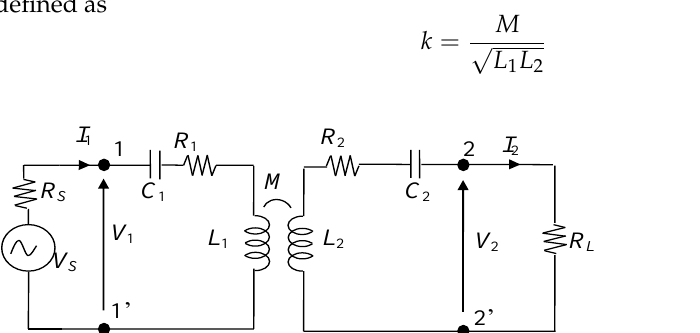
Figure 4. Equivalent circuit of wireless-power-transfer (WPT) system with series–series (SS) compensation topology.